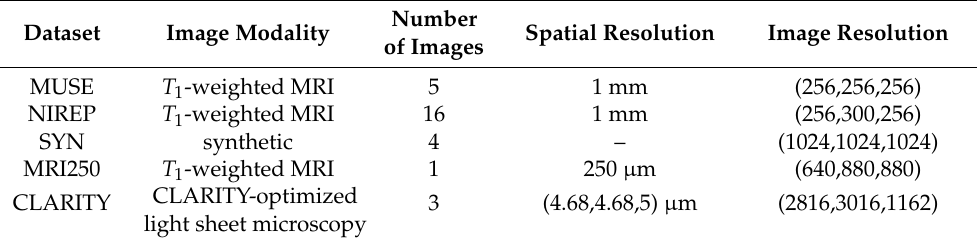
Table 2. We list the image datasets we use in our scalable registration experiments (see Section 5). All the datasets are accessible publicly and further discussed in Section 4. We list the dataset name tag (which we use to refer to them throughout the rest of the paper), the imaging modality, the number of images, the spatial resolution and the image resolution in voxels. For datasets with an isotropic spatial resolution, we only provide a single value. For datasets with anisotropic spatial resolution, we list the resolution in all three dimensions. For the SYN dataset, spatial resolution does not carry a physical meaning, so we only list the image